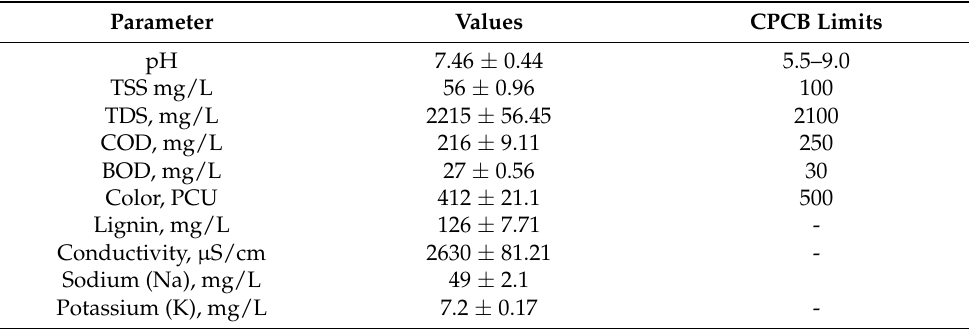
Table 2. Physico-chemical properties of effluent from Bindal paper mill.